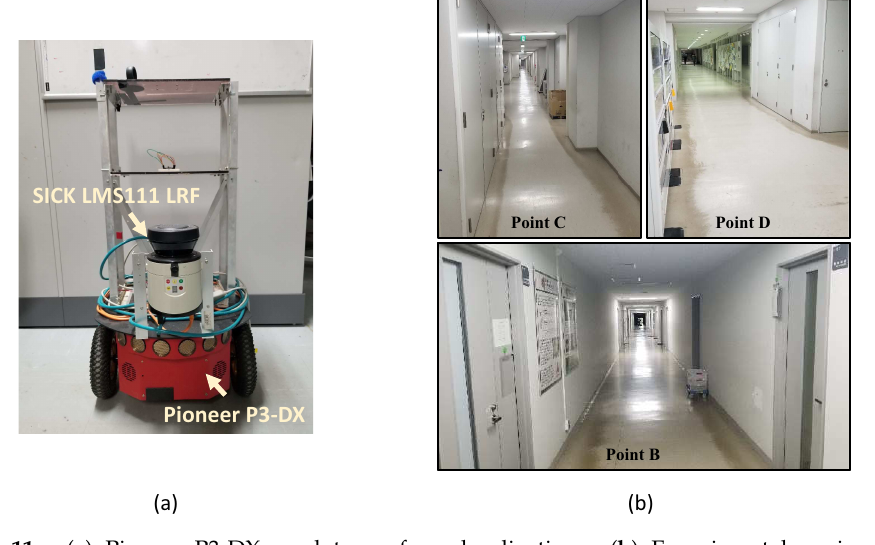
Figure 11. ( a ) Pioneer P3-DX used to perform localization. ( b ) Experimental environment, the engineering building of Hokkaido University. Table 2. The camera used in experiments.